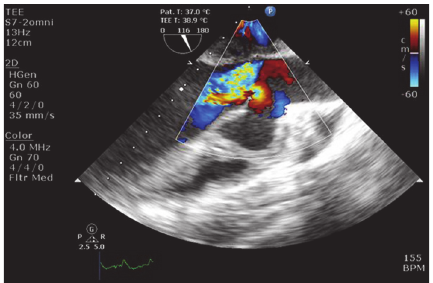
Figure 2: Transesophageal echocardiography ∗ with color Doppler revealed mild-to-moderate aortic regurgitation due to the prolapse of the left coronary cusp into the left aneurysm of sinus of Valsalva. ∗ Aortic valve long-axis view at midesophageal level.